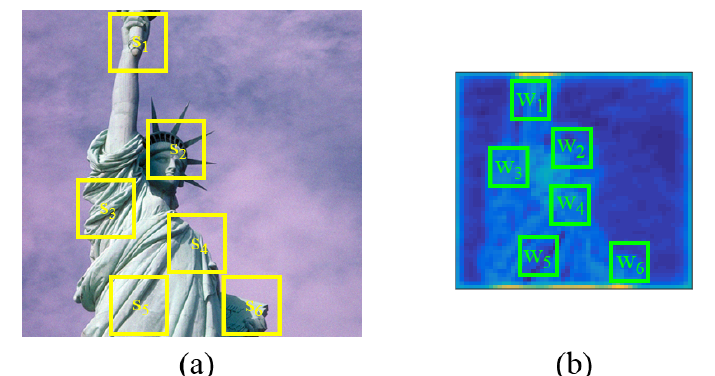
Figure 3. Visualization of the DAP. ( a ) An image sample from the CSIQ database; ( b ) the CSM in the 7th convolutional layer of the VGG-19 network. The p -th yellow rectangle is used to obtain s p ( s p represents the local quality scores of the p -th patch), and the p -th green rectangle is used to compute w p ( w p is the corresponding weight of the p -th